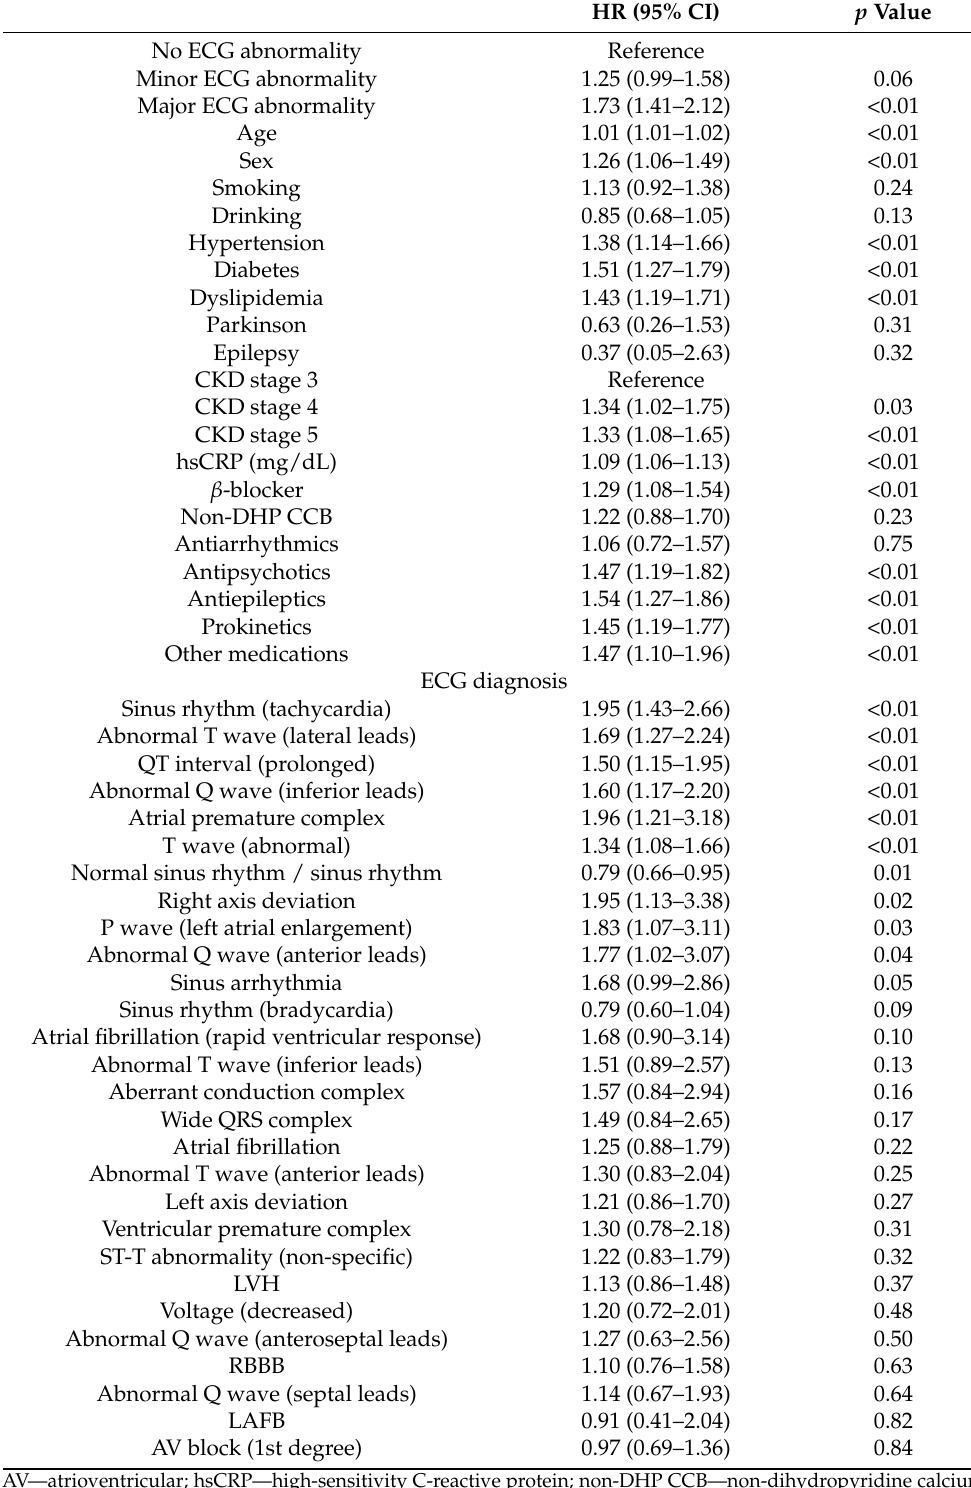
Table A3. Univariable Cox regression analysis for